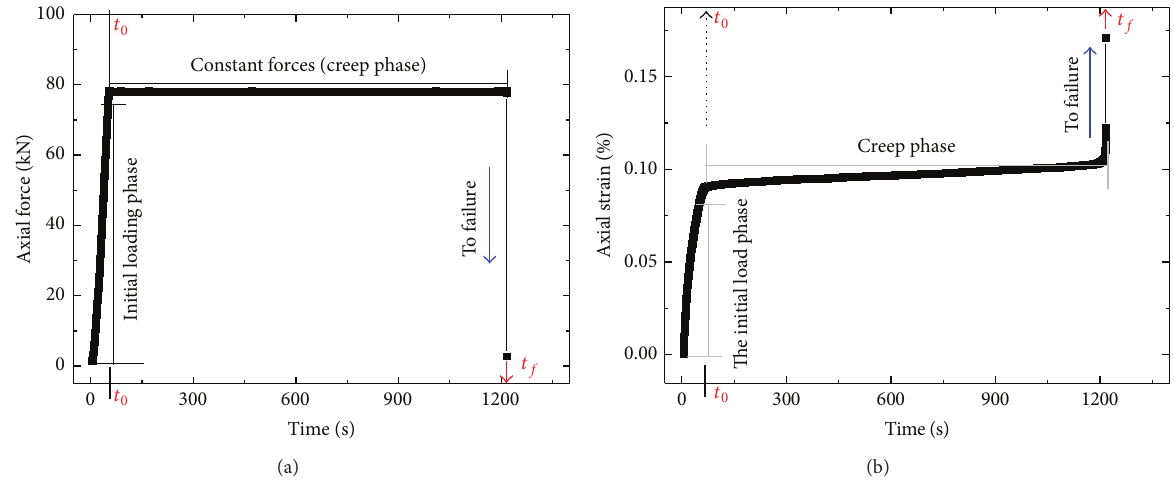
Figure 2: Force-time and strain-time plots of a typical creep experiment on concrete as an example of demonstration of the loading process. (a) The curve of axial force versus time and (b) the curve of the axial strain versus time. It is clear that the load is kept constant during the creep phase. The strain of the sample increases with time at an applied constant force and eventually leads to a sudden macroscopic failure.